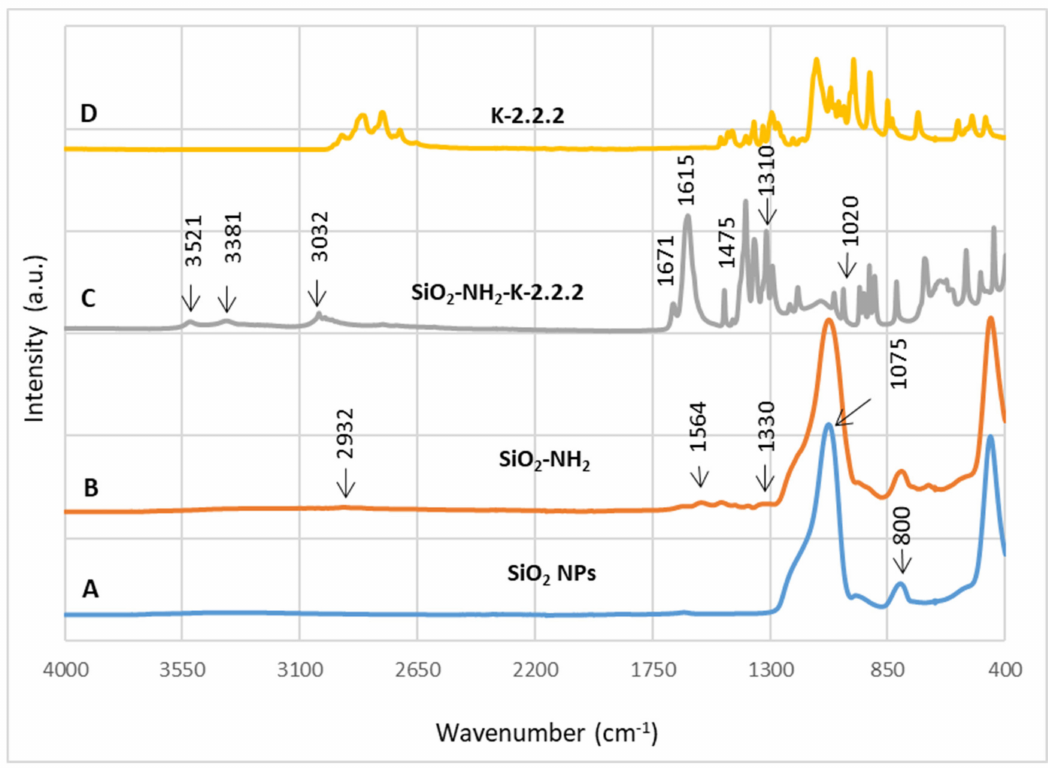
Figure 9. FTIR spectra of the ( A ) NS, ( B ) NS-APTES, ( C ) NS-APTES-K2.2.2, and ( D ) pure